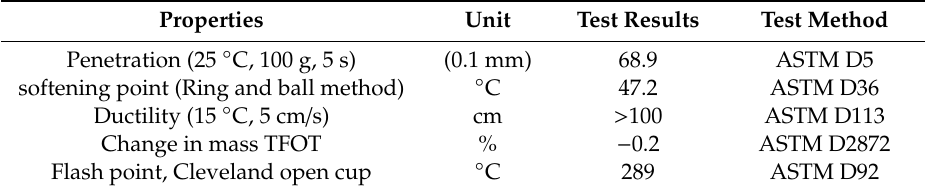
Table 1. Properties of base